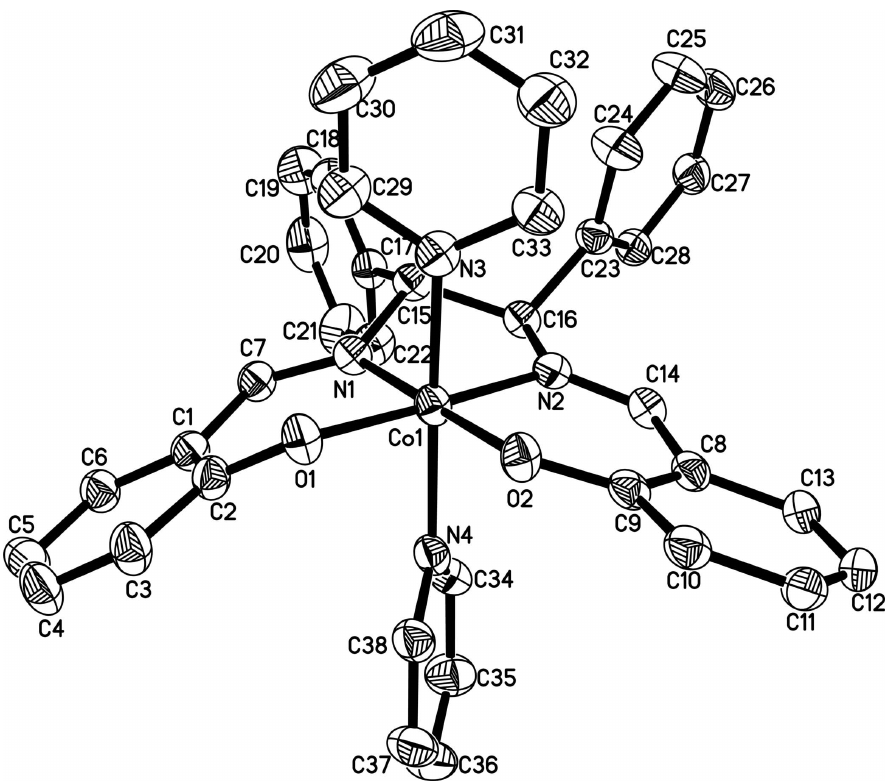
The cation of the title complex with the atom-labelling scheme. Displacement ellipsoids are drawn at the 30% probability level. H atoms are not